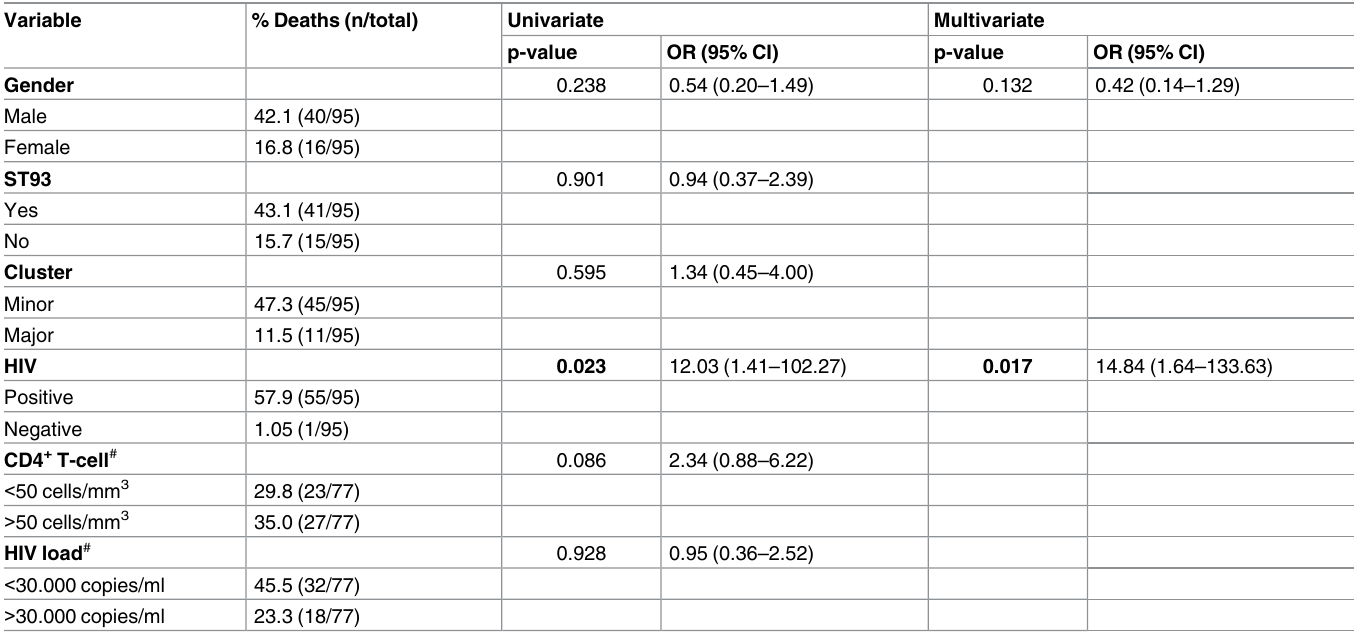
Table 1. Characteristics associatedwith deaths of the Brazilian